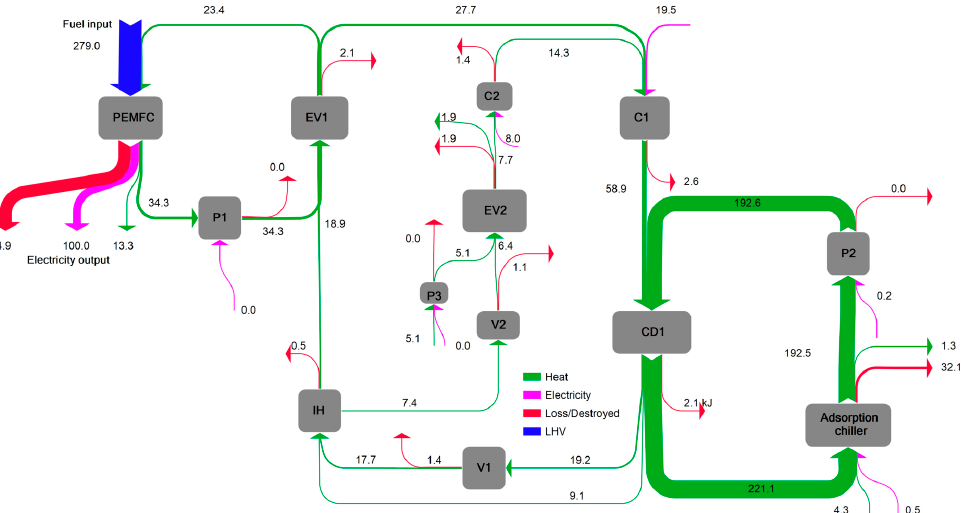
Figure 7. Sankey diagram of exergy flow within the case C system.